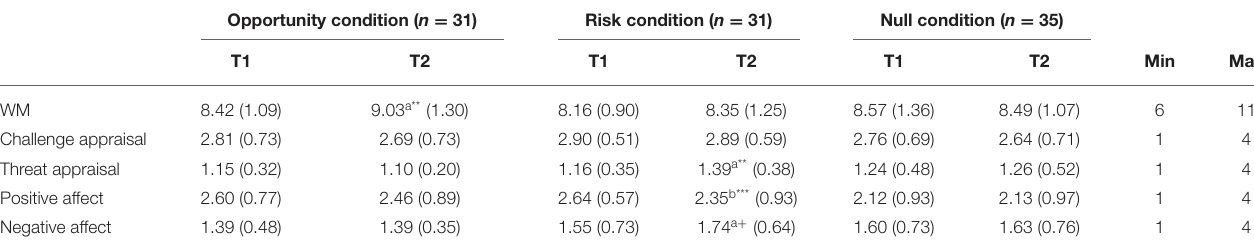
TABLE 3 | Means and standard deviations of main variables over two time points in three conditions. Opportunity condition ( n = 31)